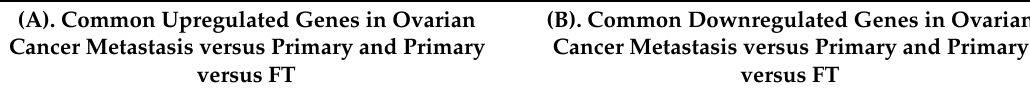
(C). Top 10 Opposite: Upregulated Genes in (D). Top 10 Opposite: Downregulated Genes